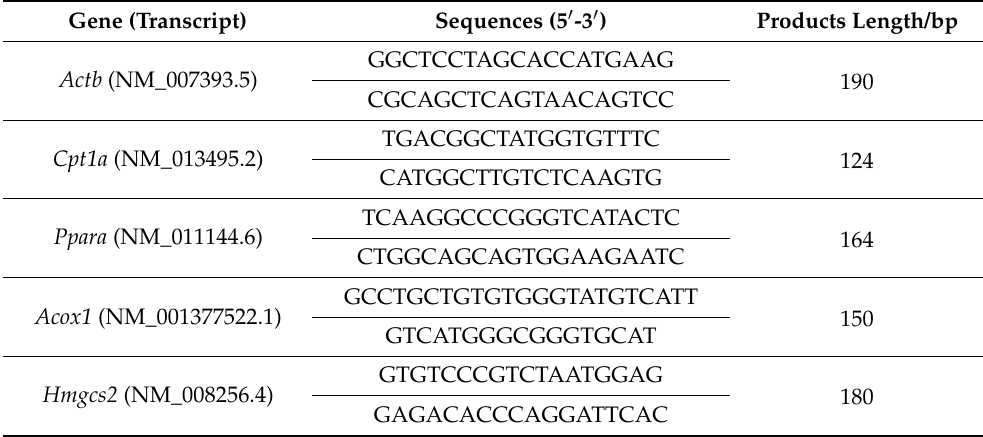
Table 1. Primer sequences used for